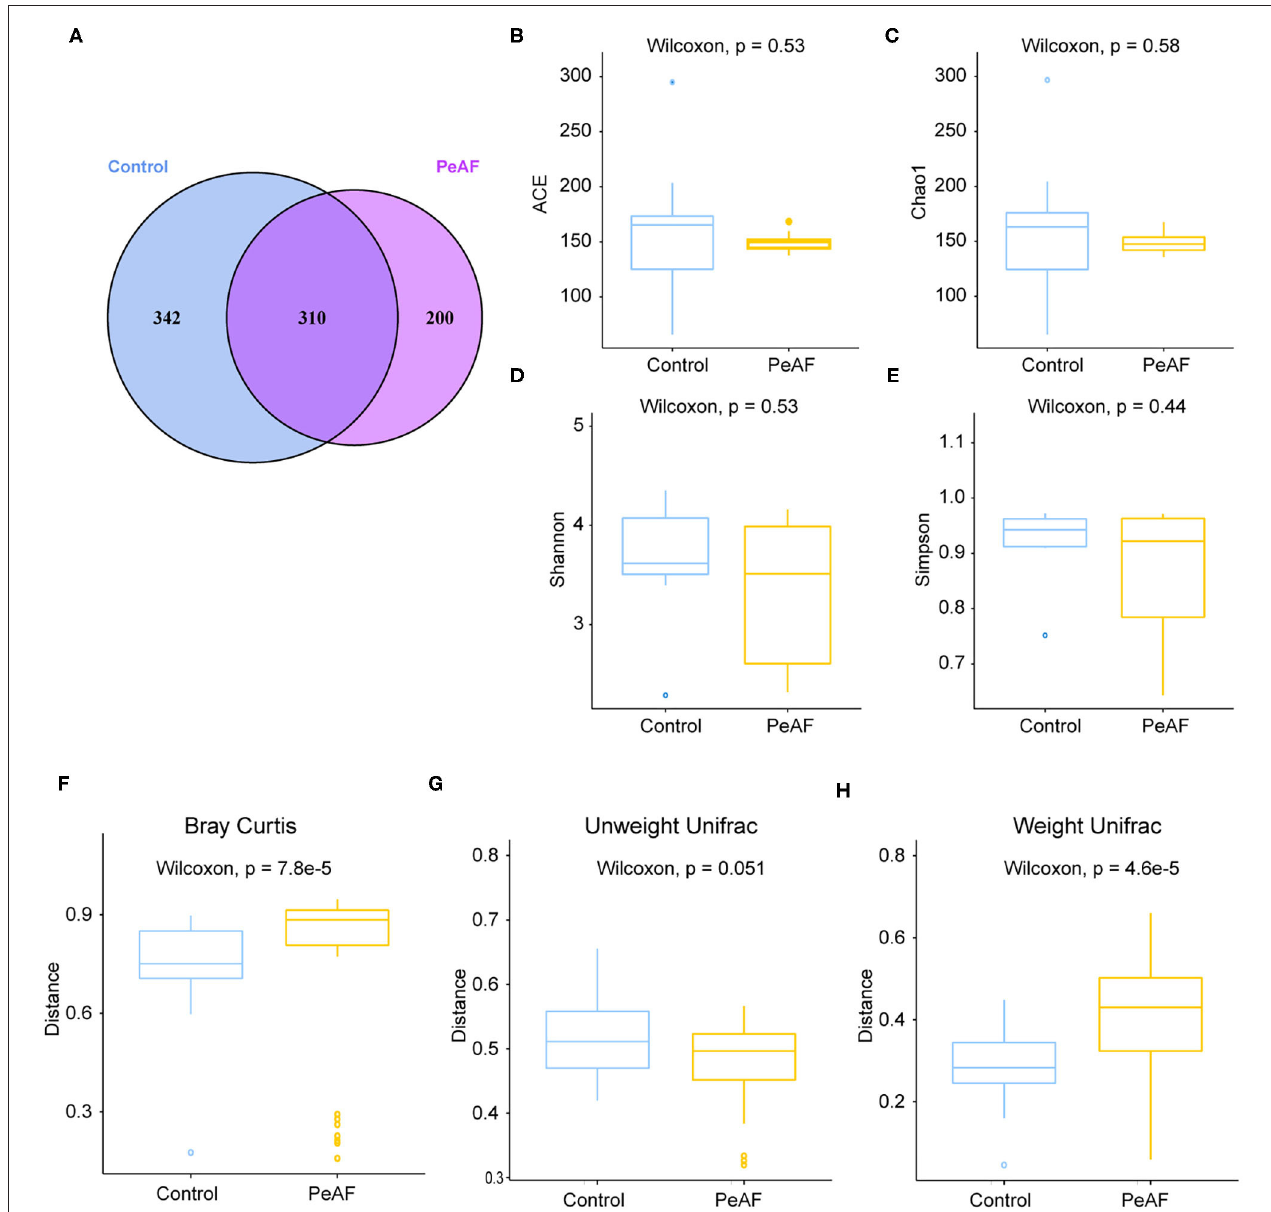
FIGURE 2 | Alterations in intestinal flora diversity. (A) Venn diagram of shared ASVs and ASVs unique to different populations. (B) ACE index. ( C) Chao1 index. (D) Shannon index. (E) Simpson index. (F) Bray-Curtis analysis. (G) Unweighted UniFrac analysis. (H) Weighted UniFrac analysis. Wilcoxon rank sum test; p < 0.05 was considered statistically significant. When 0.05 < p < 0.1, there was a relevant changing